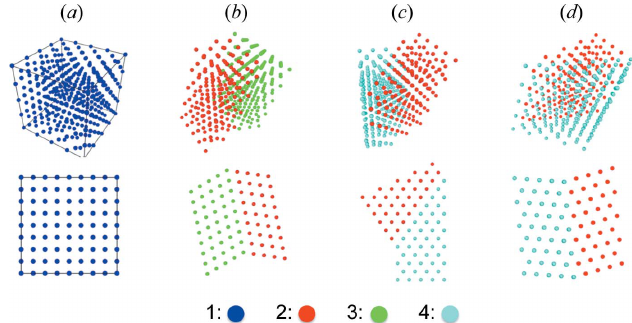
Figure 6 Atomic structures for twin boundaries generated by structural states T 1 – T 4 . ( a ) A single f.c.c. crystal at T 1 , ( b ) the (cid:2) 3 twin ( T 2 / T 3 ) on (111) T2 , ( c ) the (cid:2) 1 twin (